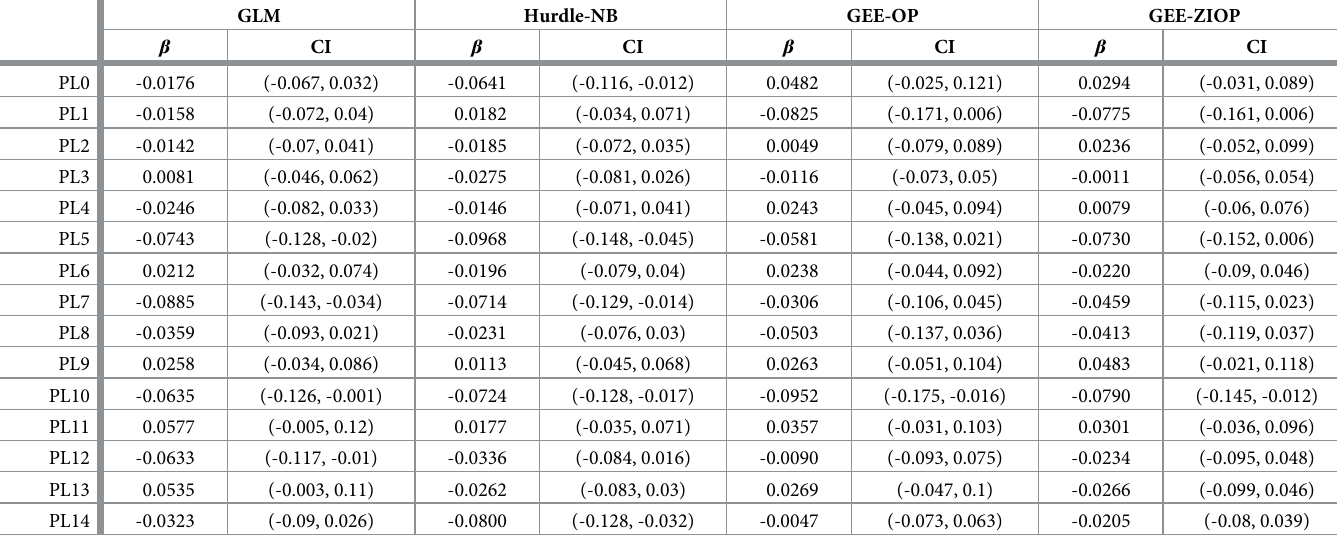
Table 4. Precipitation coefficients and 95% confidence intervals.